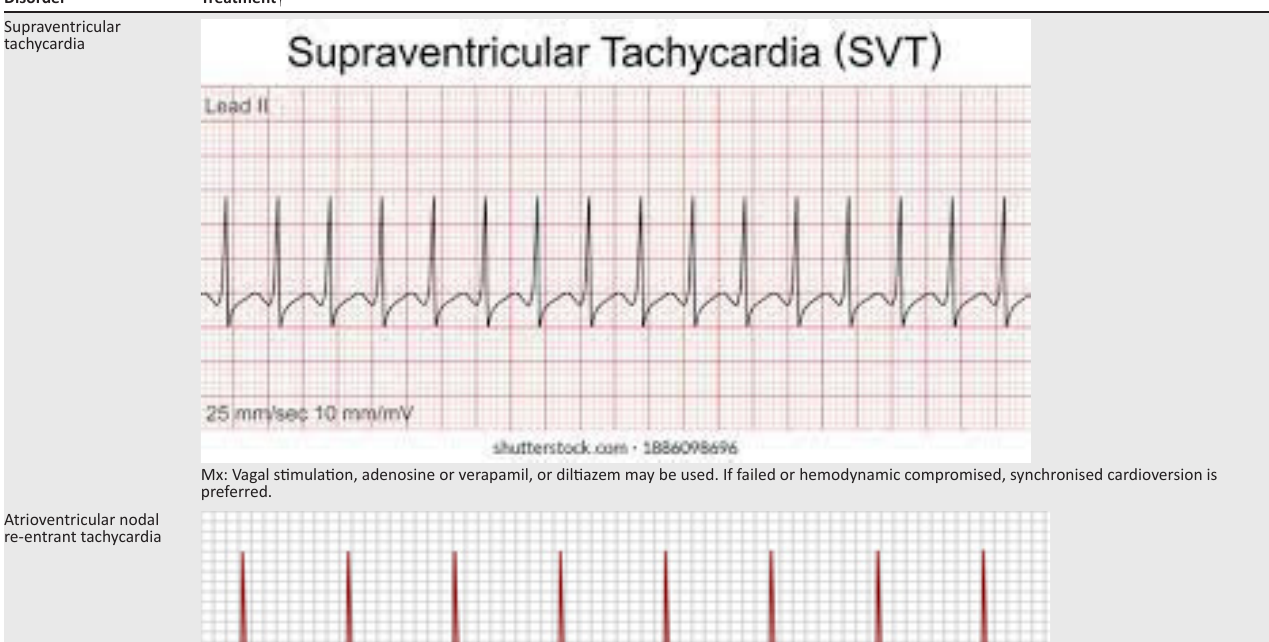
TABLE 2 (Continues…): Some treatments for arrhythmias.